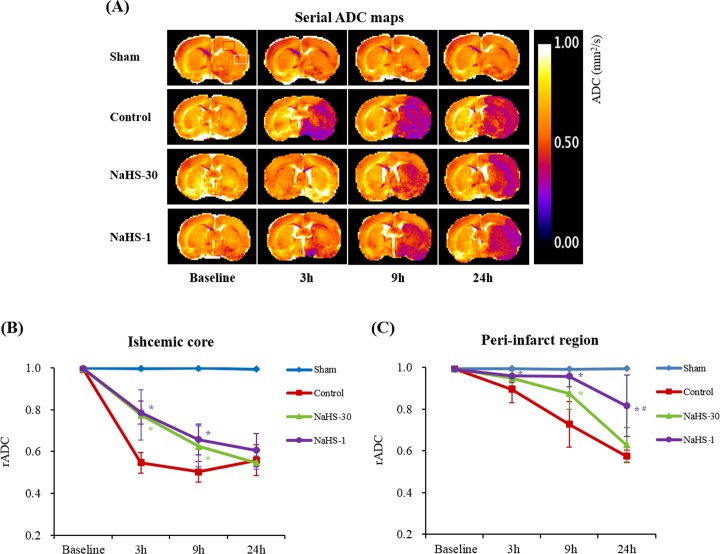
Effect of NaHS treatment on the ADC value.(A) The mean ADC values were measured in the ipsilateral (ischemic core [white square] and peri-infarct [red square]) and contralateral regions on the ADC maps at baseline and at 3, 9, and 24 h after ischemia. (B, C) The rADC of the ischemic (B) core and (C) peri-infarct regions were plotted against time. Data are presented as a mean ± standard deviation (n = 8 rats in each group). * P < 0.001 vs. the control group, # P < 0.001 vs. the NaHS-30 group.